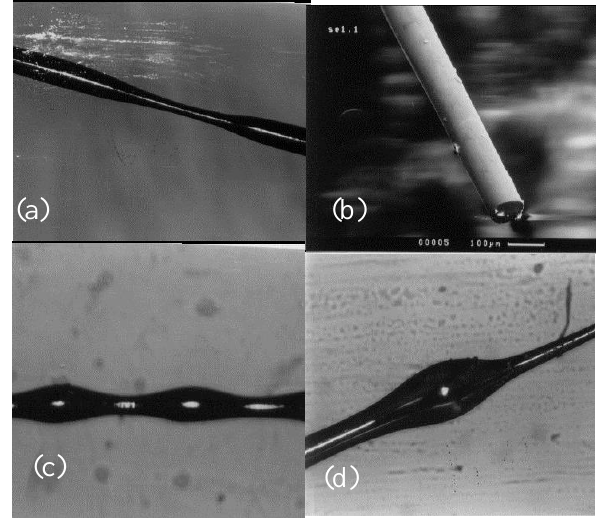
Figure 6. Some of the effects of v and SEM for ( b )) wire morphology ( a ) v ( d ) v / v = m w